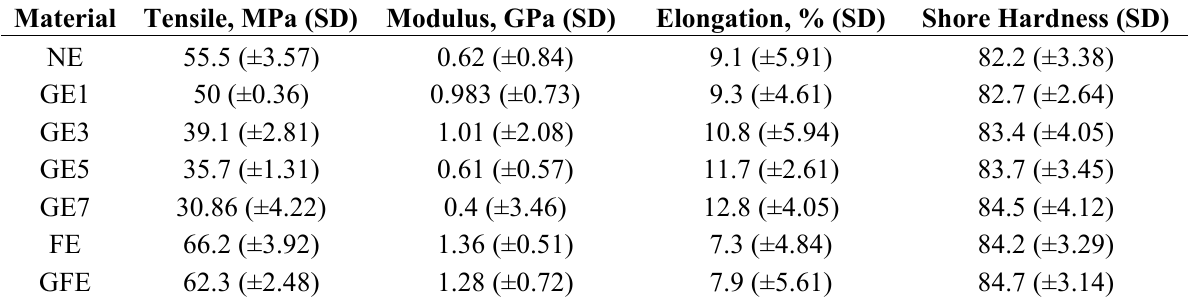
Table 2. The mechanical properties of fillers/epoxy